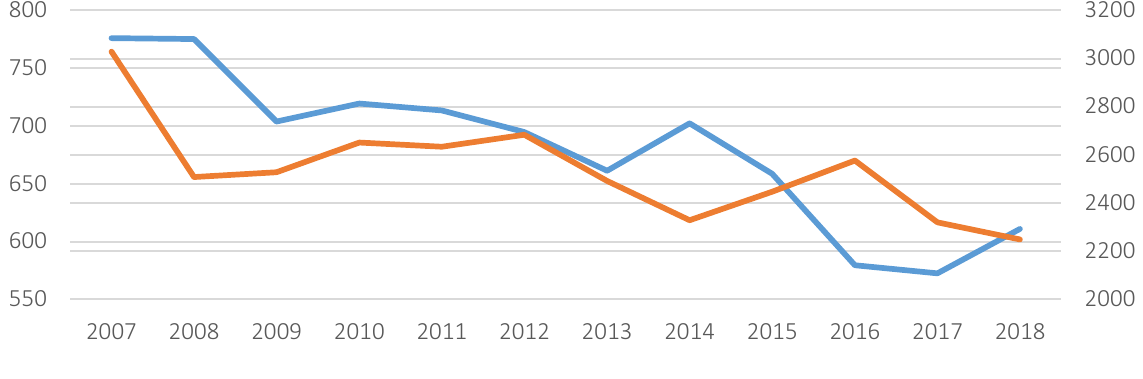
Figure 1. Dynamics of final energy consumption and waste generation per unit of industrial value-added in Ukraine, 2007–2018